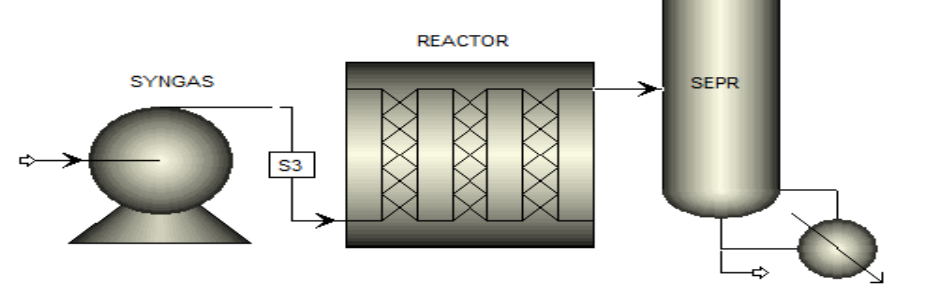
Figure 1. FTS Reactor. Table 1. Reactor